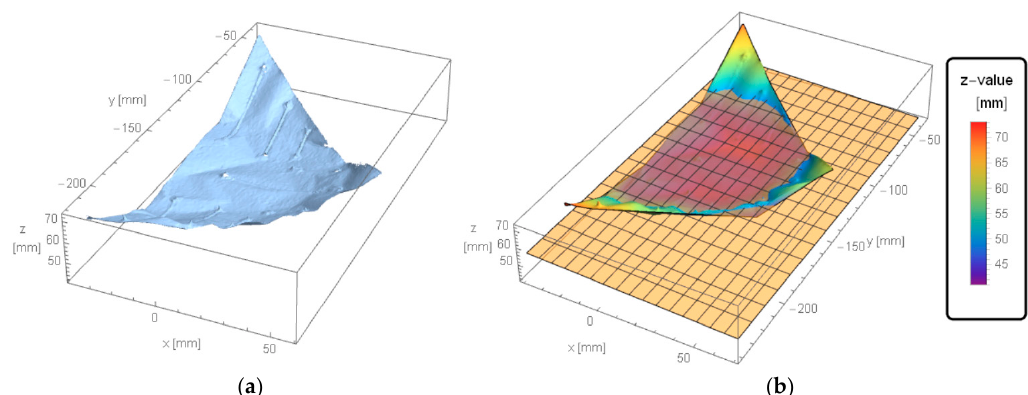
Figure 4. Original point for the first configuration ( a ) and after rotation and translation ( b ).